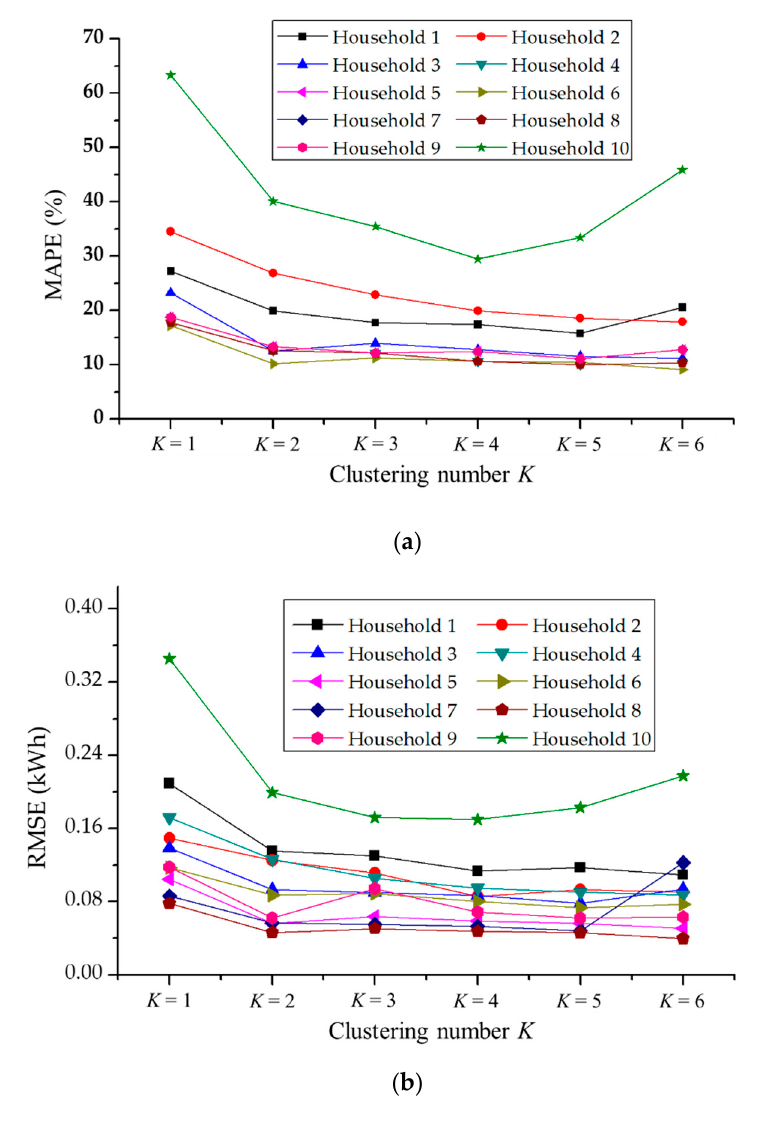
Figure 12. Effect of clustering number K on forecasting accuracy: ( a ) MAPE, and ( b ) RMSE. Figure 12. E ff ect of clustering number K on forecasting accuracy: ( a ) MAPE and ( b )